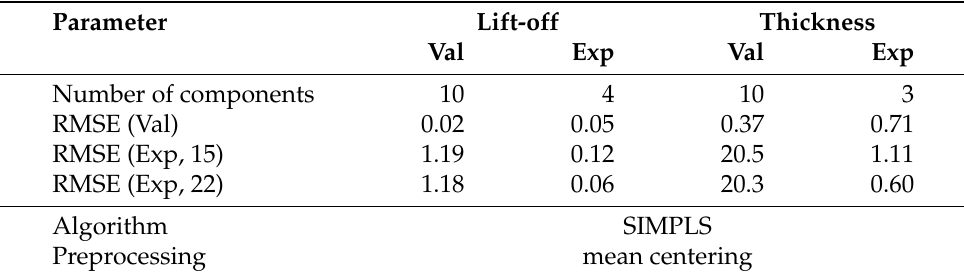
Table 3. Parameters of Partial Least Squares regression (PLSR) models and corresponding RMSE values (Val model optimized using simulated validation set, Exp model optimized using the experi- mental data).